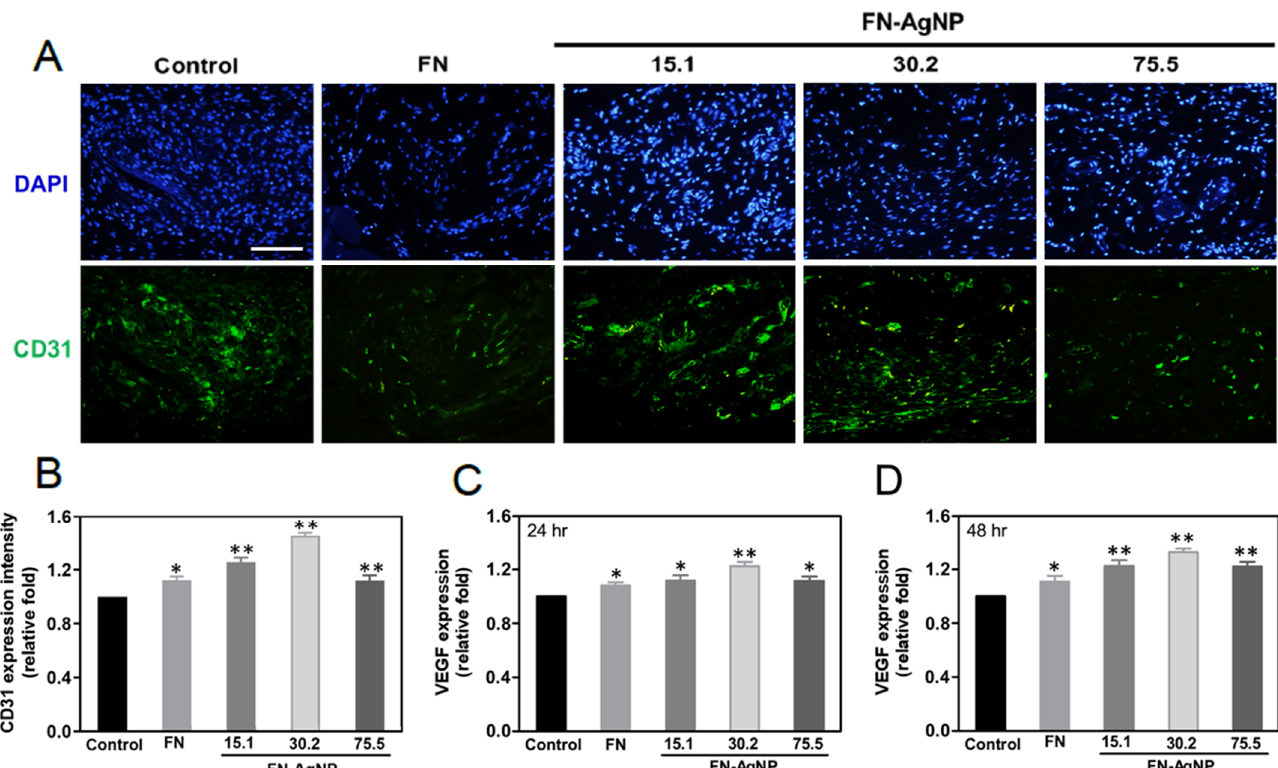
Figure 7. Immunohistochemistry staining for endothelialization marker CD31 affected by the implant materials. ( A ) The histology images for CD31 were showed after implanting various materials for 4 weeks. Scale bar = 100 µ m. ( B ) The CD31 expression was also investigated and then semi-quantified according to fluorescence intensity. * p < 0.05; ** p < 0.01: higher than the control ( n = 5). ( C , D ) The expression level of VEGF protein was evaluated via ELISA assay at 24 and 48 h, then the fluorescence intensity were semi-quantified by Image J software. Data are the mean ± SD. * p < 0.05; ** p < 0.01: greater than the control ( n = 5).